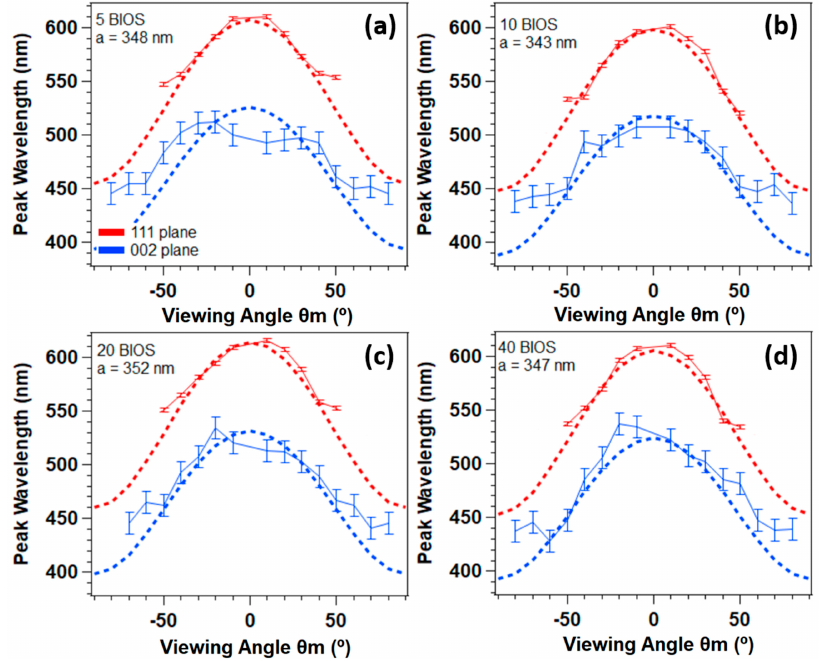
Figure 4. Extracted peak wavelengths are fit against the Bragg-Snell law for polymer opals of ( a ) 5, ( b ) 10, ( c ) 20, and ( d ) 40 BIOS shear passes, where the peak wavelengths are shown to display good agreement with origins from the {111} plane and {002} plane groups.